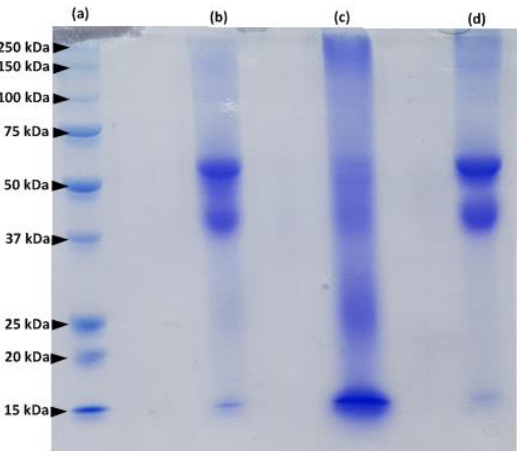
Figure 2. SDS–PAGE of a molecular weight markers (lane a); human nail extract (lane b); bovine hoof extract (lane c) and human hair extract (lane d).